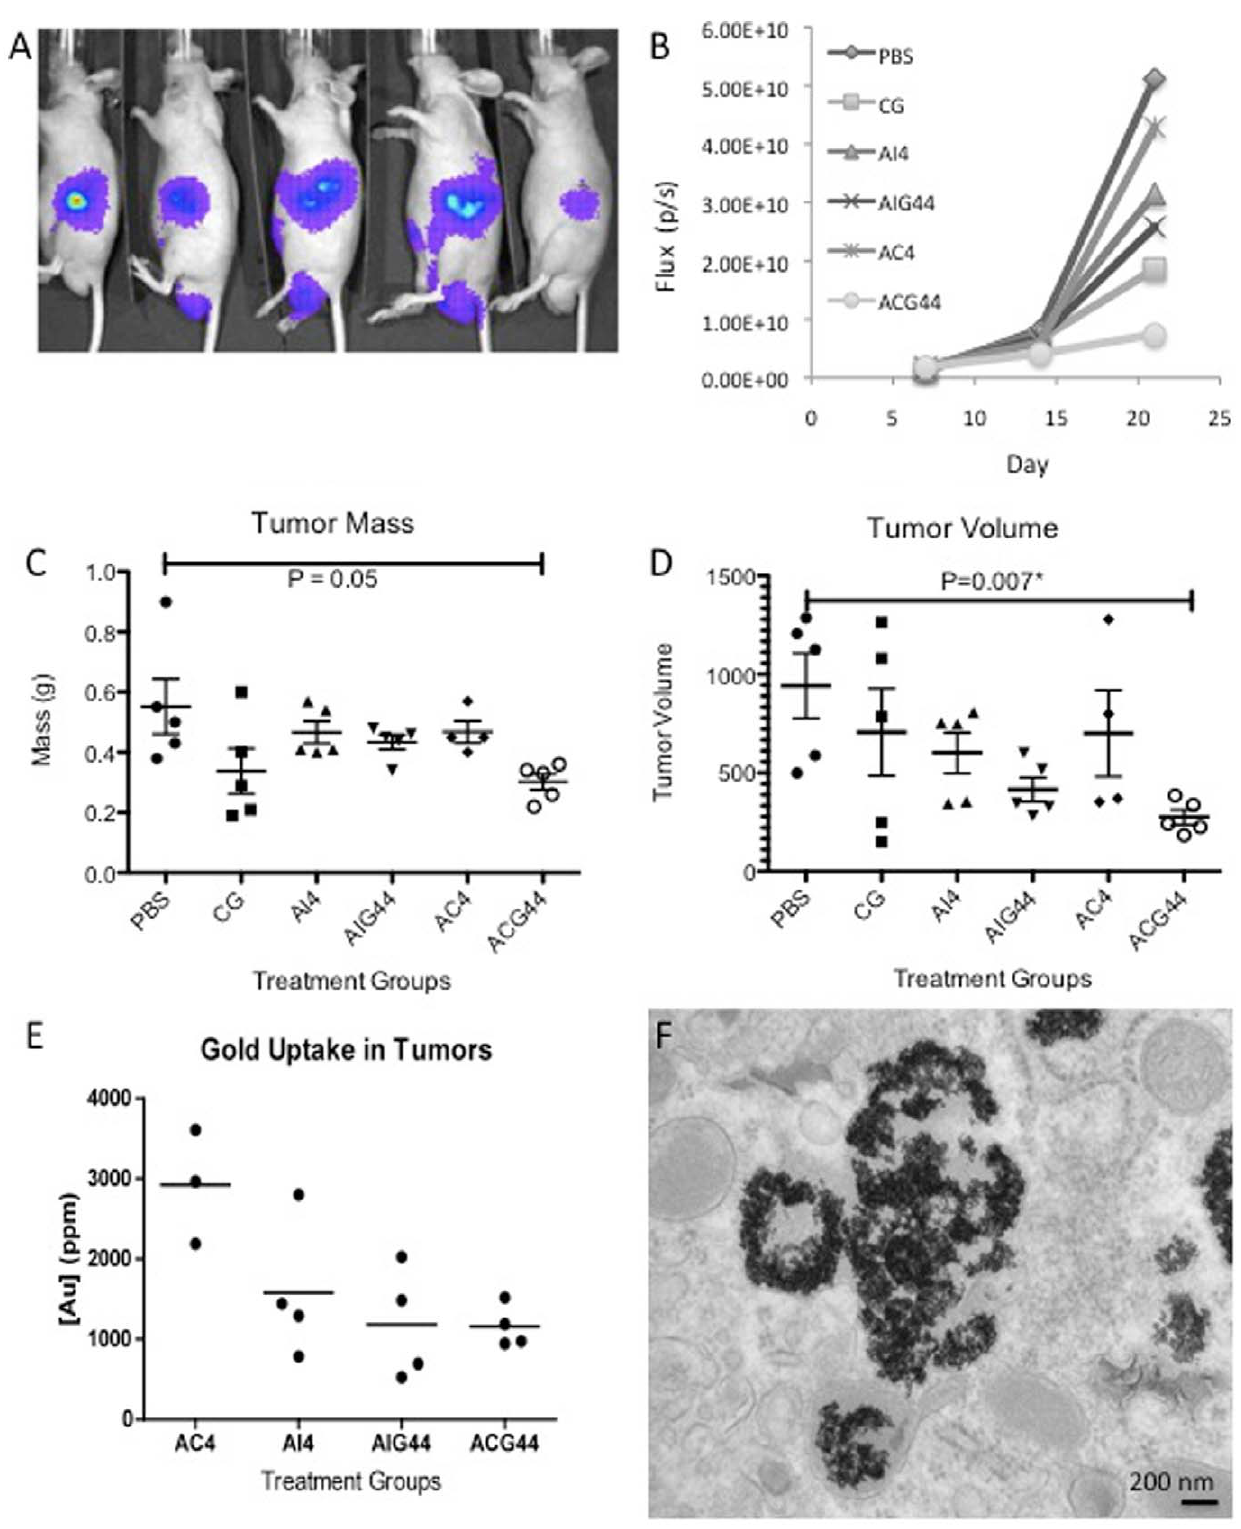
Figure 3. Invivo effects of gold nanoconjugates in an orthotopic model of pancreatic cancer. Figure 3A shows a representative bioluminescence image of 5 mice, 7 days after orthotopic implantation of AsPC-1 cells into the pancreas. Figure 3B is flux quantification from the bioluminescence imaging taken every 7 days. Figure 3C, 3D and 3E all show scatter plots of tumor analysis of each animal per group, post study termination. Figure 3C shows tumor mass, 3D shows tumor volume determined through caliper measurements and 3E shows total gold uptake in each tumor determined by INAA. Figure 3F is a TEM micrograph showing ACG44 conjugates in a cross section of tumor tissue.